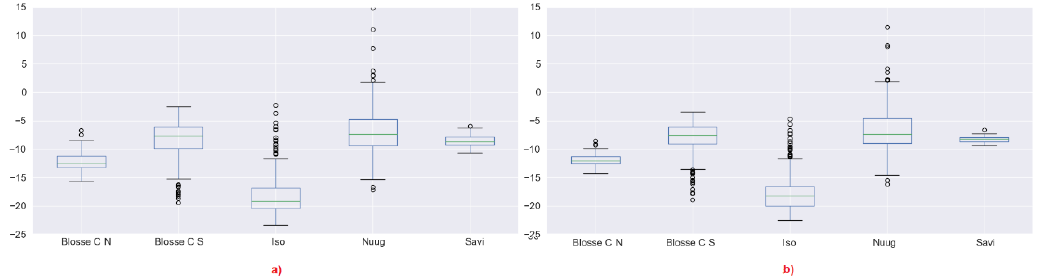
Figure 9. ( a ) Iceberg span boxplot 5 × 5 window, ( b ) 11 × 11 window. Large entropy changes are most significant in Blosseville Coast N and Savissivik. Dots indicate outliers.